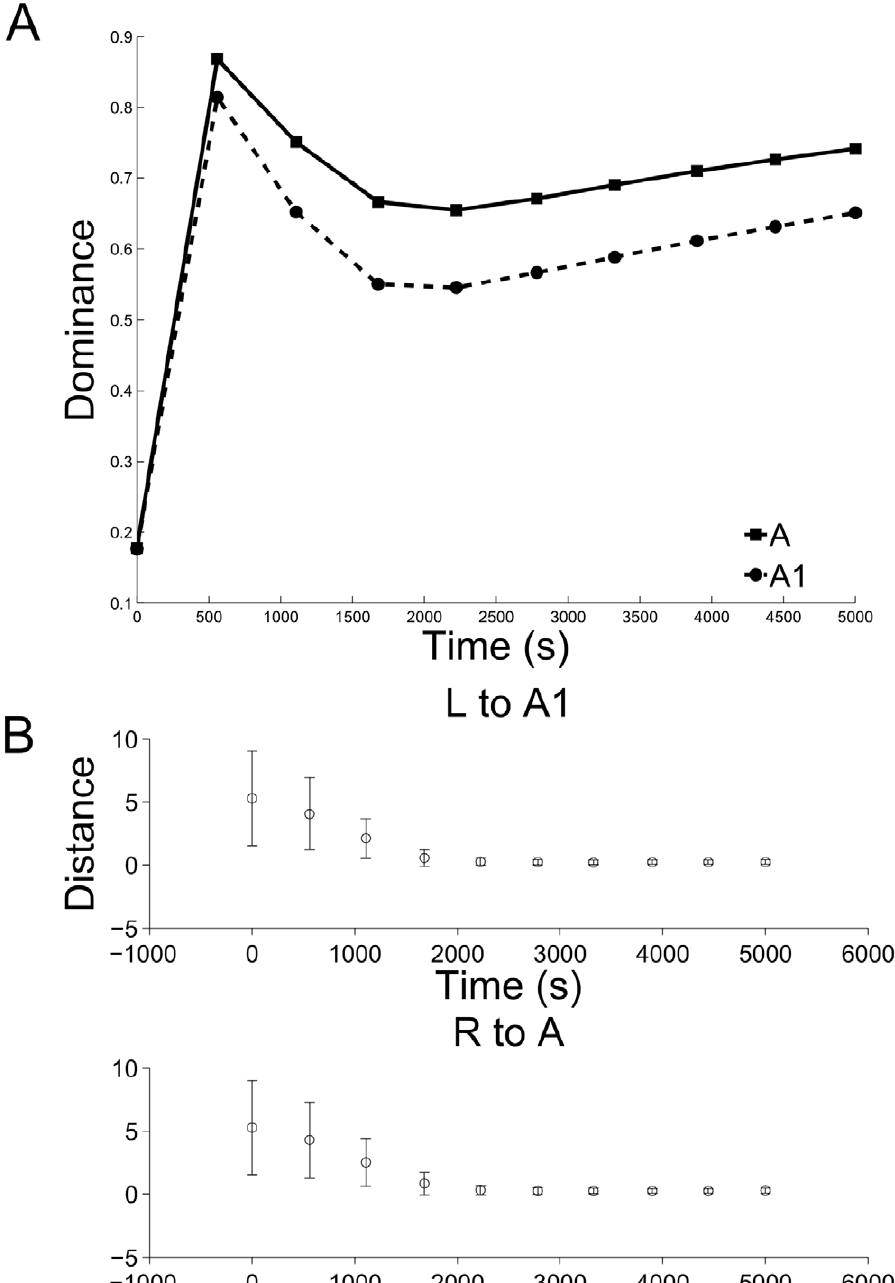
Figure 8. Simulation of retinogeniculate development. (A) The normalized dominance of the initially biased eye grows. For both layers A and A1, the eye that is initiated with weights slighter larger than the other comes to ‘dominate’ that layer over the course of 5,000 s of waves (see (22)). (B) Additionally, the mean distance of the CoM from an ideal CoM for the retinogeniculate weights decreases, indicating that the weights projecting to each dLGN cell become increasingly refined; in particular, ectopic projections are pruned away.